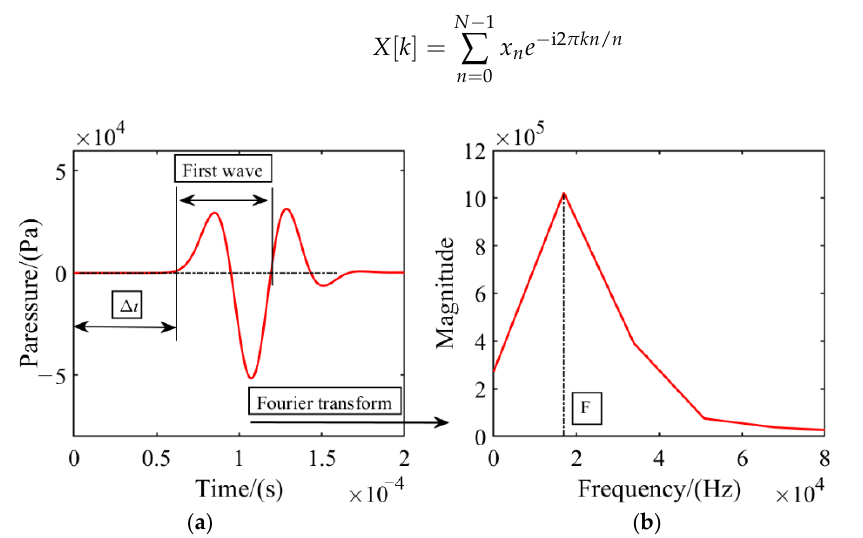
Figure 3. Fourier transform of the received signal. ( a ) Time—domain signal; ( b ) Frequency—domain signal.